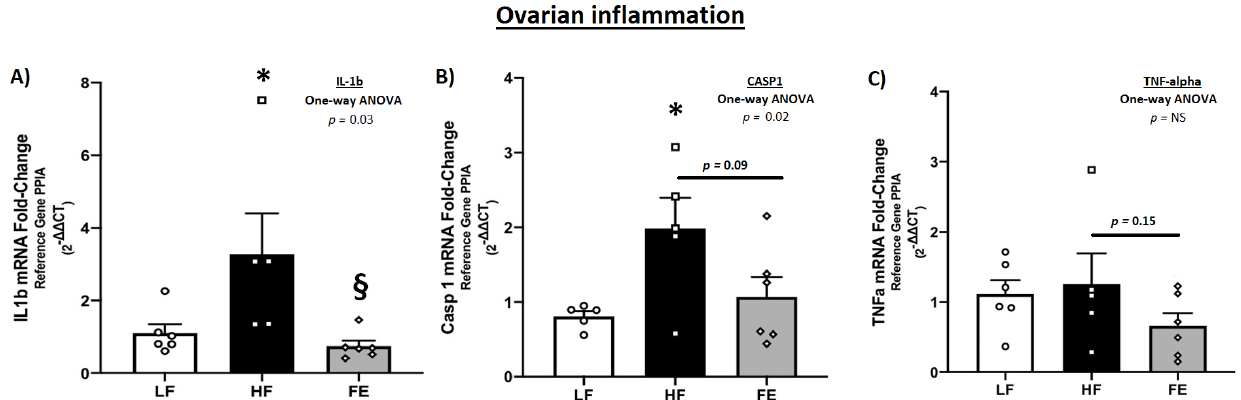
Figure 11. Effects of the ‘Fertility Enhancer’ supplement on key drivers of the inflammatory cascade in ovarian tissue of Western diet-fed C57BL/6J mice. ( A ) Ovarian IL-1 β mRNA. ( B ) Ovarian CASP1 mRNA. ( C ). Ovarian TNF- α mRNA. LF = Low Fat Diet, HF = Western Diet (WD), and FE = ‘Fertility Enhancer’ multi-nutrient supplement with WD. * Significantly different from LF ( p ≤ 0.05). § Significantly different from HF ( p ≤ 0.05).